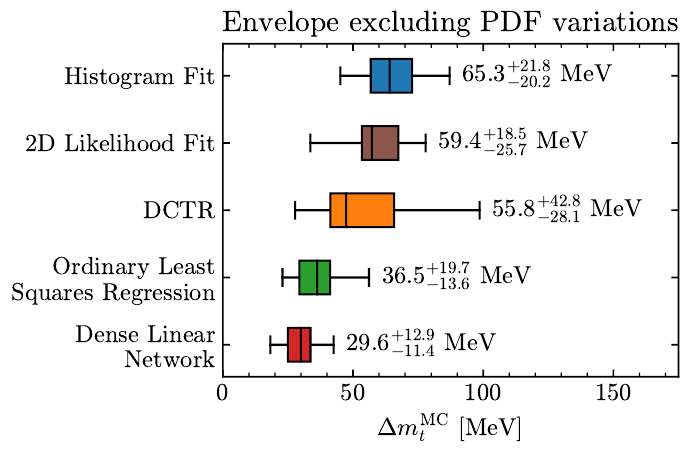
Figure 1. Summary of main results. The bars show the estimate of the Monte-Carlo tuning un- certainty in top-quark mass extraction from top events at the LHC. The errors on the uncertainties include uncertainties from training and statistical variations. The top row is a histogram fit, using soft drop and normalizing to the W -mass (following [30]). The second row uses a 2D likelihood fit to profile over correlations between the top and W masses. The third row uses the DCTR technique of [34]. The fourth row is an ordinary least squares linear regression on an ensemble of 30,000 events. The fifth row shows the result of using a linear network for regression, also on an ensemble of 30,000 events. Numbers here correspond to the total envelope excluding PDF uncertainties, as in figure